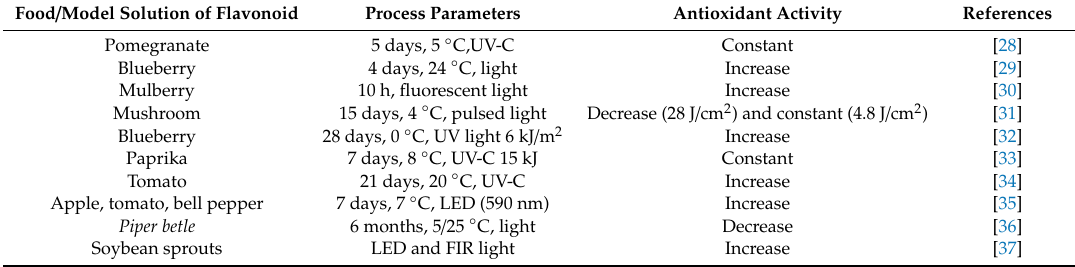
Table 2. Review on the studies dealing with the evolution of antioxidant activity during a storage under light conditions.